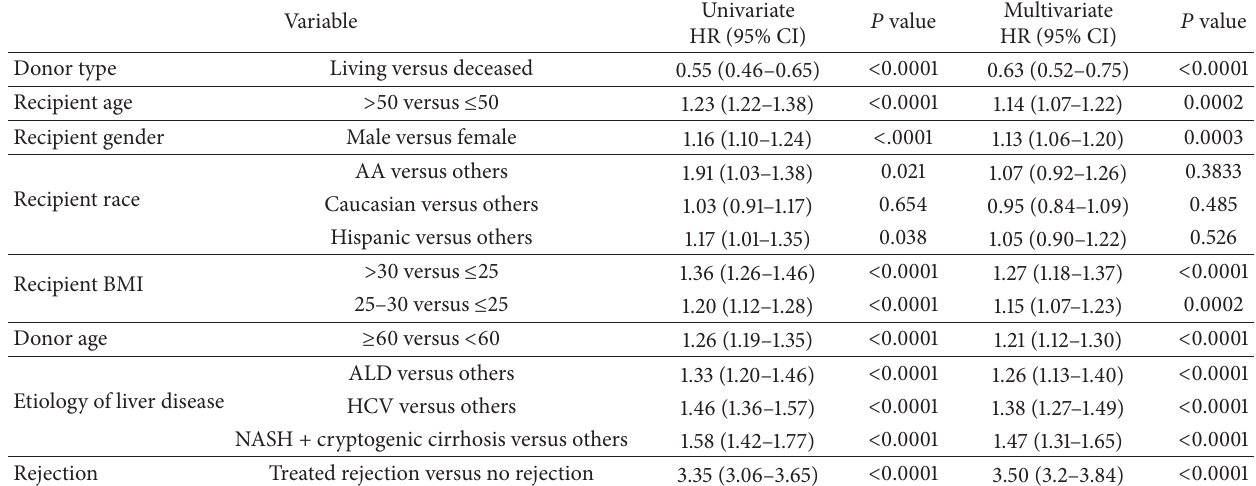
Table 2: Association of risk factors for development of NODAT for all LT recipients ( 𝑛 = 20 ,